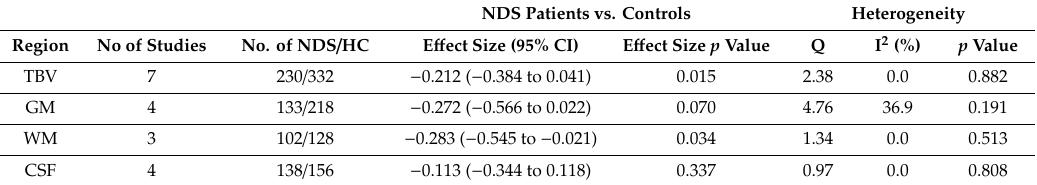
Table 4. Meta-analysis of continuous data comparing patients with non-deficit schizophrenia vs. healthy controls (HC).